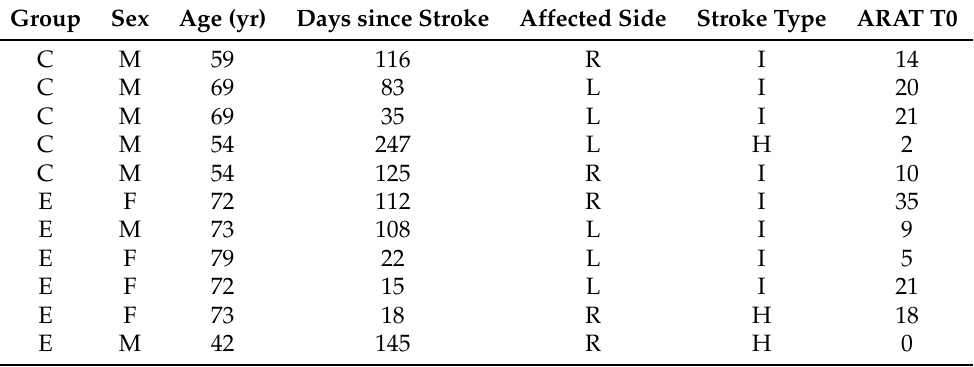
Table 1. Demographic data of the participants in the control group (C) and in the experimental group (E). I: Ischemic. H: